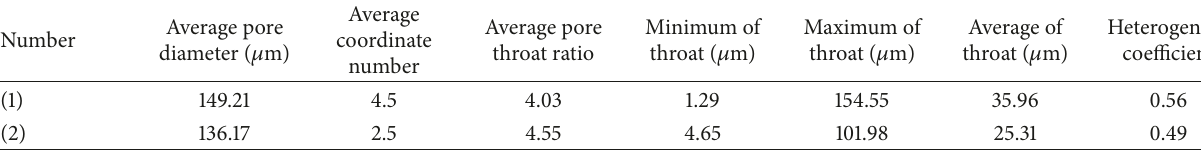
Table 1: Parameters of pore structure in the geological models.